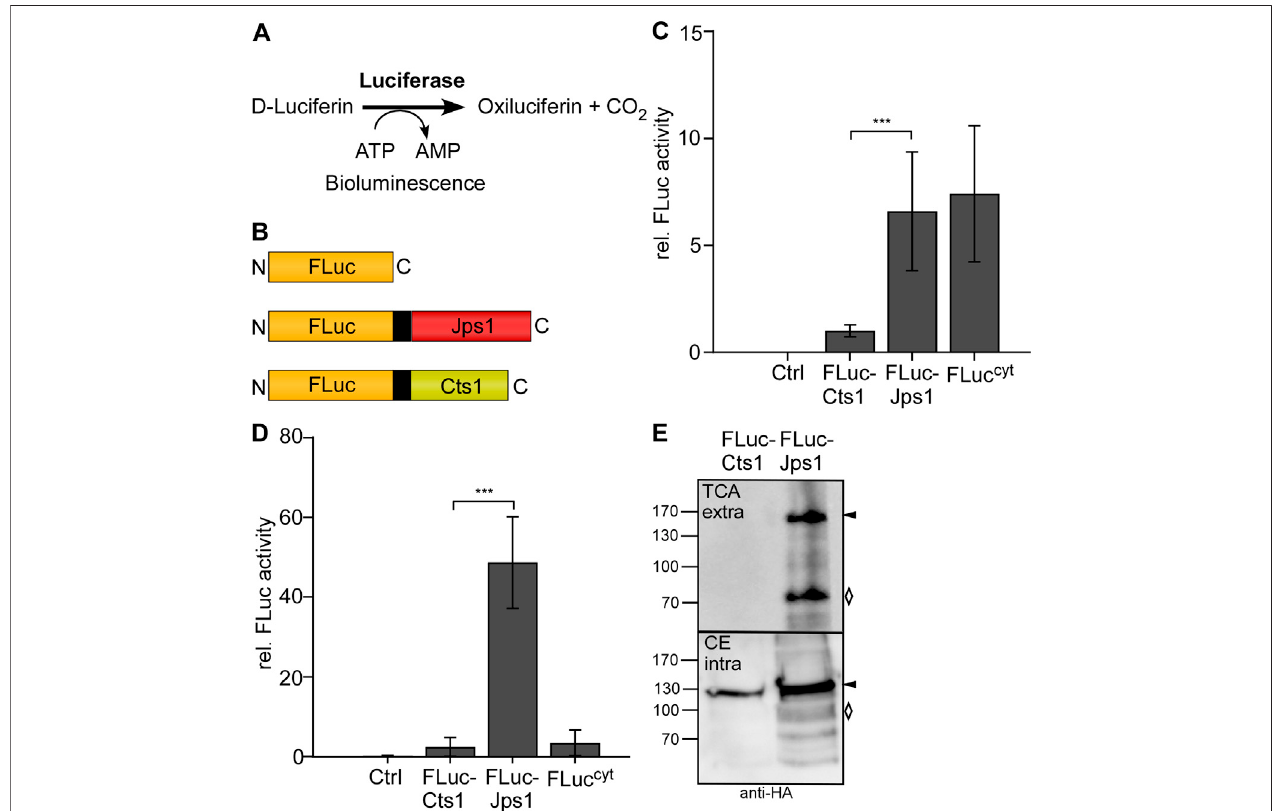
FIGURE 3 | Ef fi cient Jps1-mediated export of fi re fl y luciferase as a new reporter for unconventional secretion. (A) Schematic display of the proteins expressed to study unconventional secretion. Cytoplasmic FLuc (FLuc cyt ) was used as a lysis control (top). FLuc-Jps1 (middle) and FLuc-Cts1 (bottom) harbor the respective carrier proteins at the C-terminus. All proteins carry an SHH tag indicated in black (Sarkari et al., 2014). All schemes are drawn to scale. (B) Enzymatic reaction mediated by fi re fl yluciferase: D-Luciferin and ATPare converted tooxiluciferin,AMP and CO 2 . During thisreaction excited intermediates emit energy inthe form oflightthat can be detected as bioluminescence. (C) Comparison of intracellular FLuc activity of the strains AB33P8 Δ /FLuc-Cts1 and AB33P8 Δ /FLuc-Jps1. Enzymatic activity was normalized to average values of strain secreting FLuc-Cts1. The progenitor strain AB33P8 Δ was used as a negative control. Strain AB33 FLuc cyt with intracellular FLuc expression dealt as positive control. Three biological replicates are shown. (D) Comparison of extracellular FLuc activity of strains harboring either Cts1 or Jps1 as a carrier. Enzymatic activity was normalized to average values of strain secreting FLuc-Cts1. Strain AB33 FLuc cyt with intracellular FLuc expression dealt as lysis control. Three biological replicates are shown. Error bars in fi gures (C) and (D) indicate standard deviation. De fi nition of statistical signi fi cance (***): p -value < 0.05. p -value was derived from Student ’ s unpaired t -test. (E) Representative Western blot of FLuc-Cts1 and FLuc-Jps1. Secreted protein was enriched from the supernatant by TCA precipitation. Intracellular protein levels were visualized by cell extracts. Western blots show 1 ml of precipitated supernatants (TCA) and 10 μ g cell extracts (CE). Full length protein signals indicated by arrows, degradation bands with a rhombus.